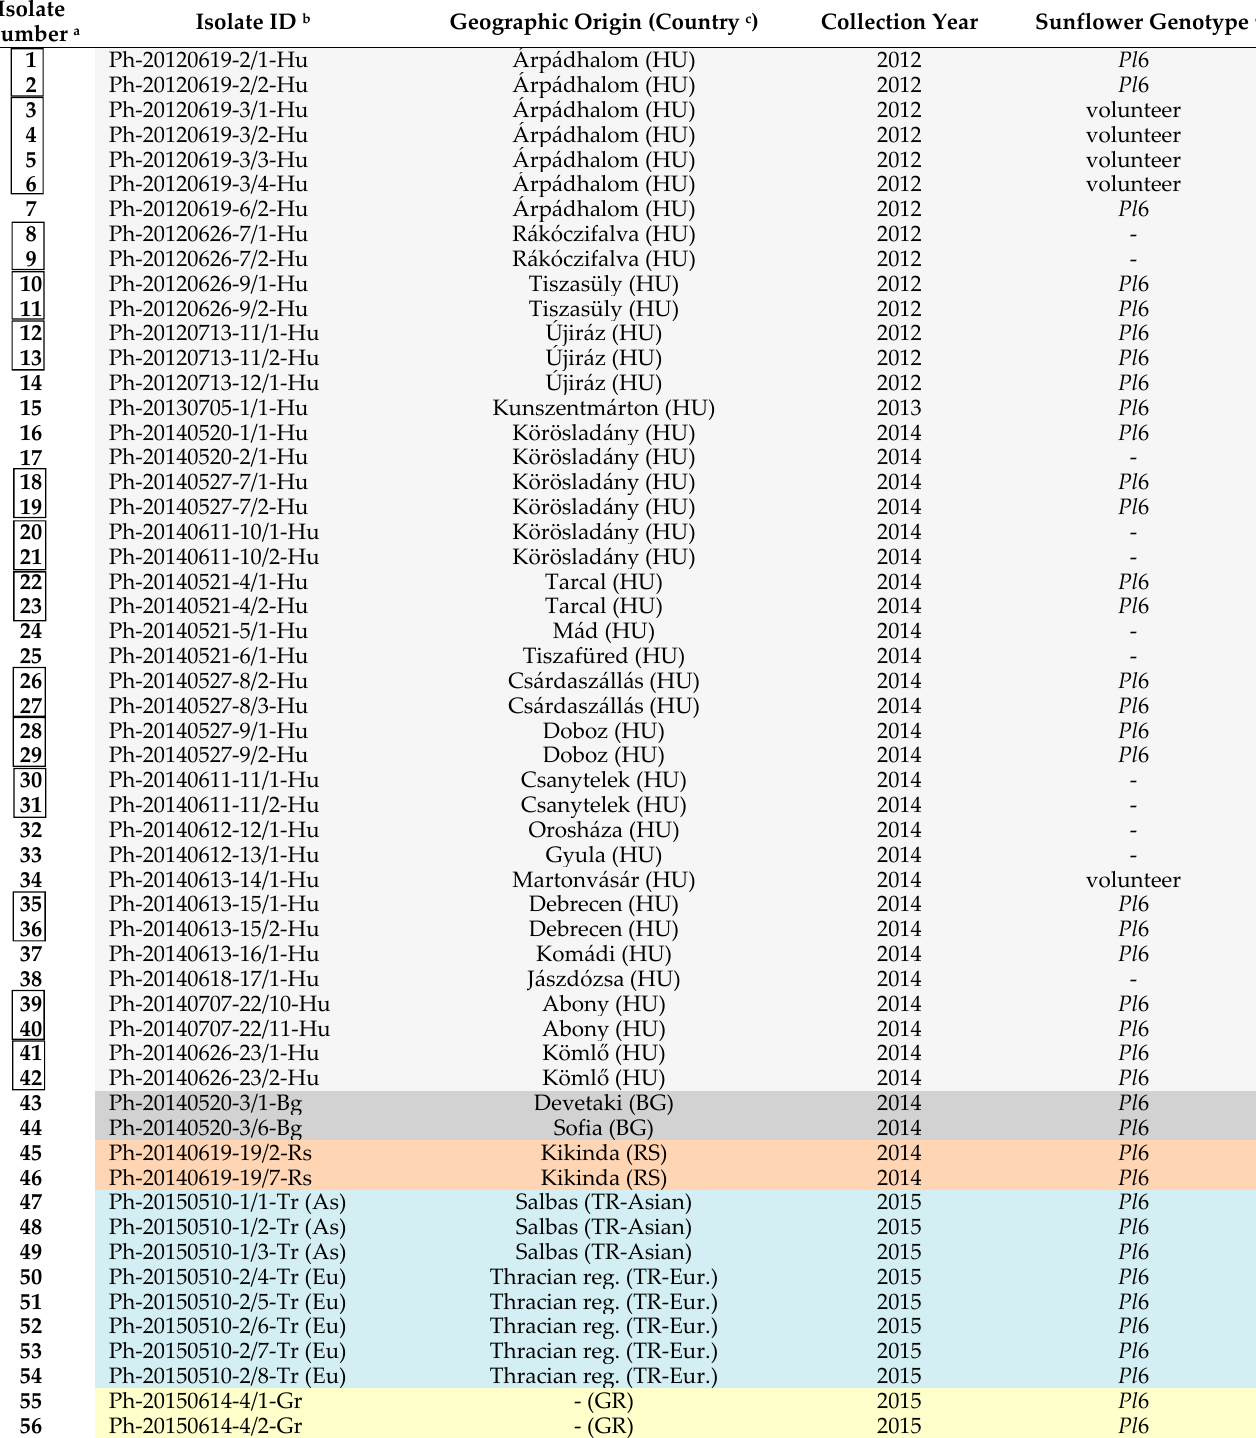
Table 1. List of Plasmopara halstedii isolates collected from seven countries in Europe (2012–2019).